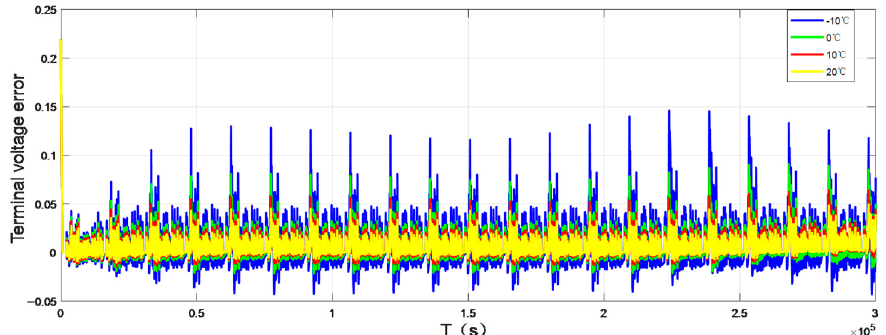
Figure 5. Terminal voltage error curve at low temperature.